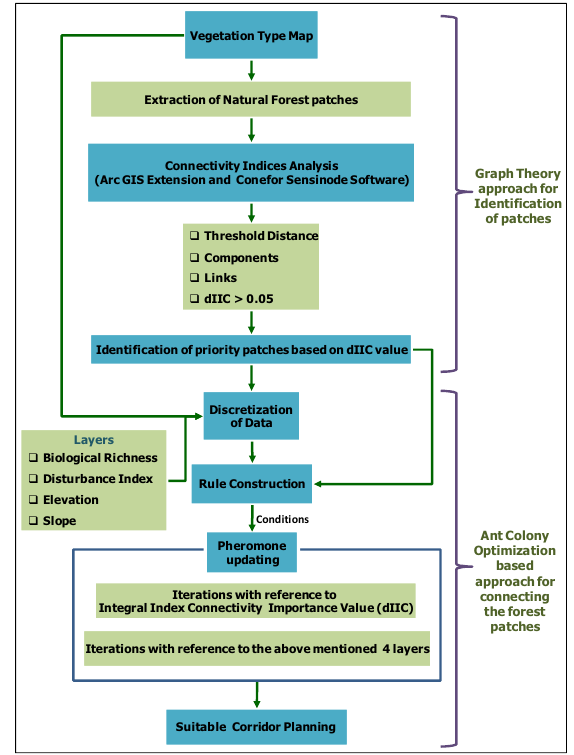
Figure 2: Flow Chart for Graph Theory and Ant Colony Optimization Technique for forest patch